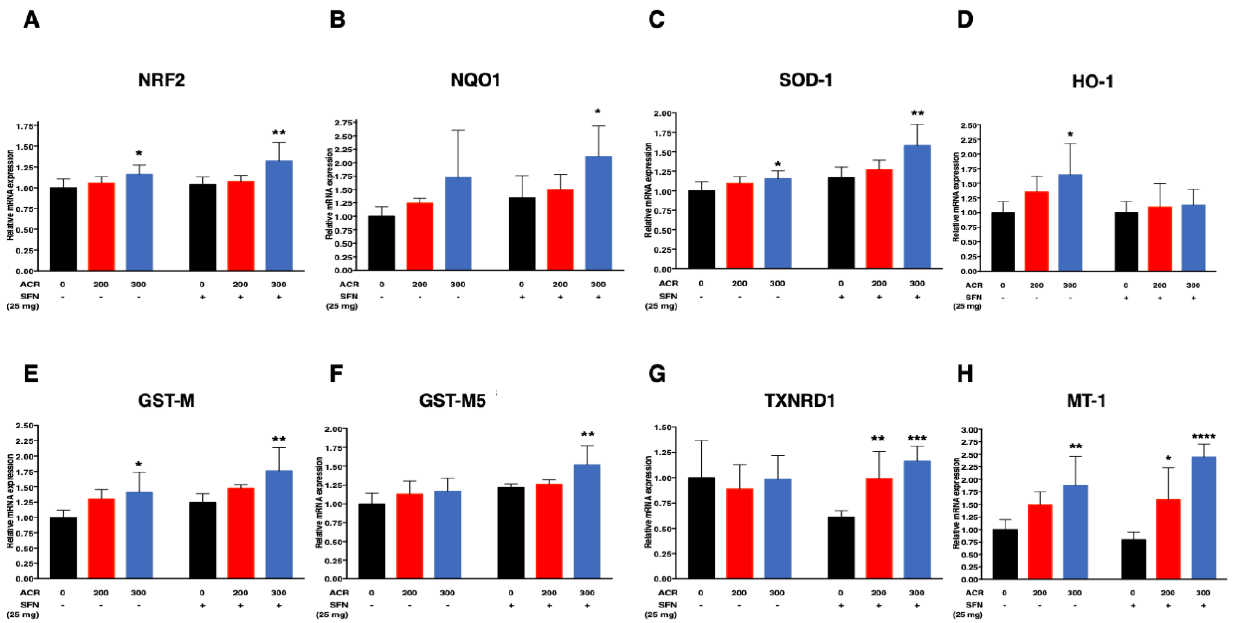
Figure 6. Effects of the combination of acrylamide and sulforaphane on relative mRNA expression of Nrf2 antioxidant genes in the cerebral cortex, Nrf2 ( A ), NQO1 ( B ), SOD-1 ( C ), HO-1 ( D ) GST-M ( E ), GST-M5 ( F ), TXNRD1 ( G ) and MT-1 ( H ) after exposure to acrylamide for 4 weeks. Data are mean ± SD. * p < 0.05, ** p < 0.01, *** p < 0.001, **** p < 0.0001, compared to the corresponding control (by ANOVA followed by Dunnett’s multiple comparison). [ n = 6].